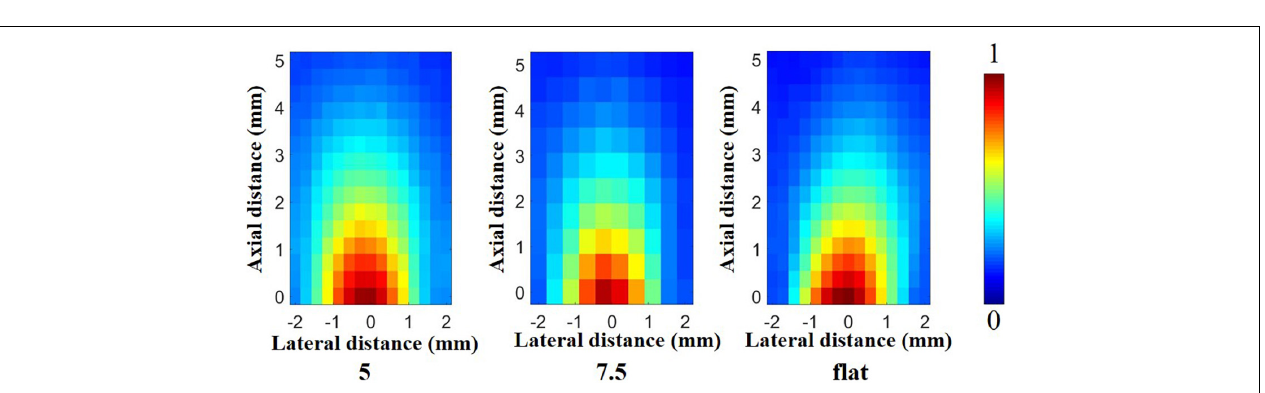
FIGURE 6 | (A) Manufacture process of dimpling, (B) the structure diagram of the half-concave ultrasonic transducer, (C) dimpled pic255 piezoelectric ceramic, and (D) the packaged ultrasonic transducers.